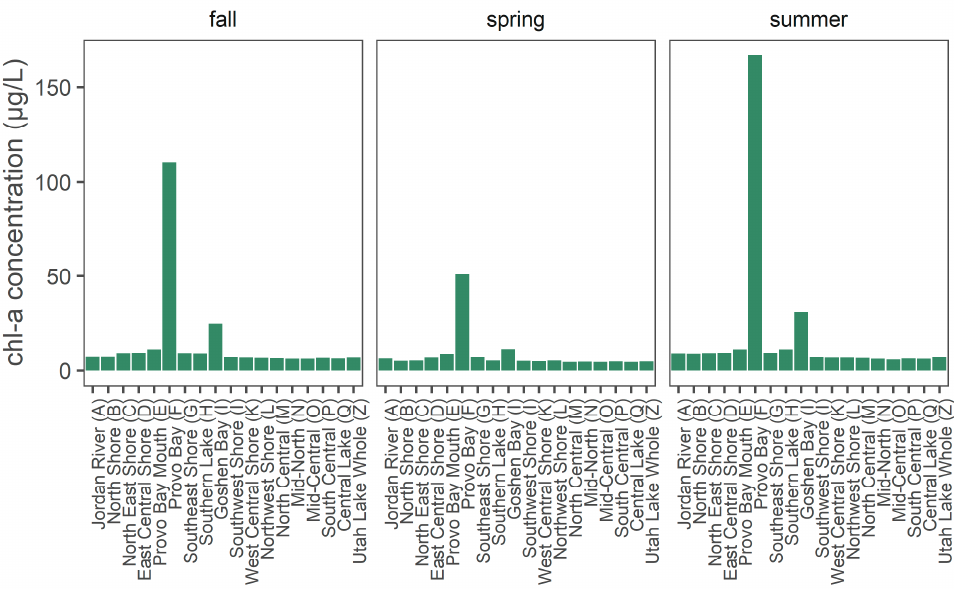
Figure 13. Seasonal median chl-a values by location.